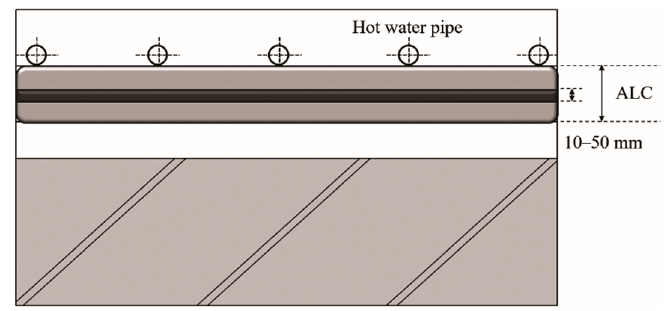
Figure 13. Application method of 10–50 mm PCM. ALC: autoclaved lightweight concrete.